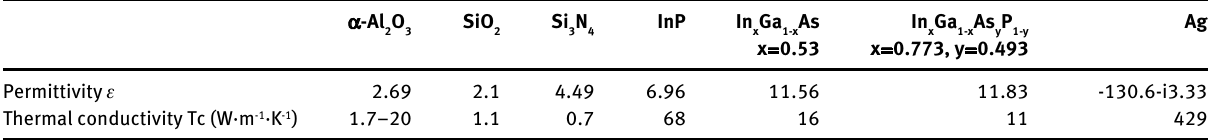
Table 1 Optical and thermal properties of materials used in numerical modeling, at 1550 nm and 300 K (Reprinted from [23]).